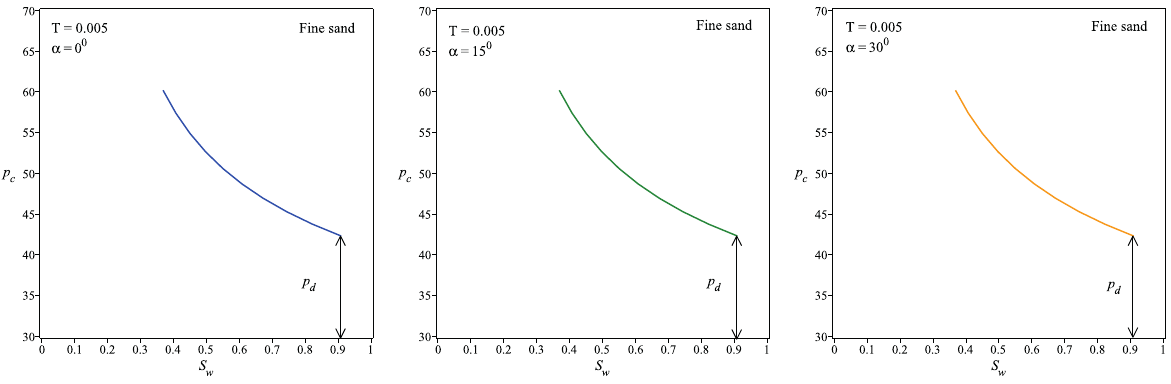
Fig. 7: Capillary pressure vs. Saturation in Heterogeneous Porous Media for Fine Sand at different inclined plane α = 0 ◦ , 15 ◦ , 30 ◦ .